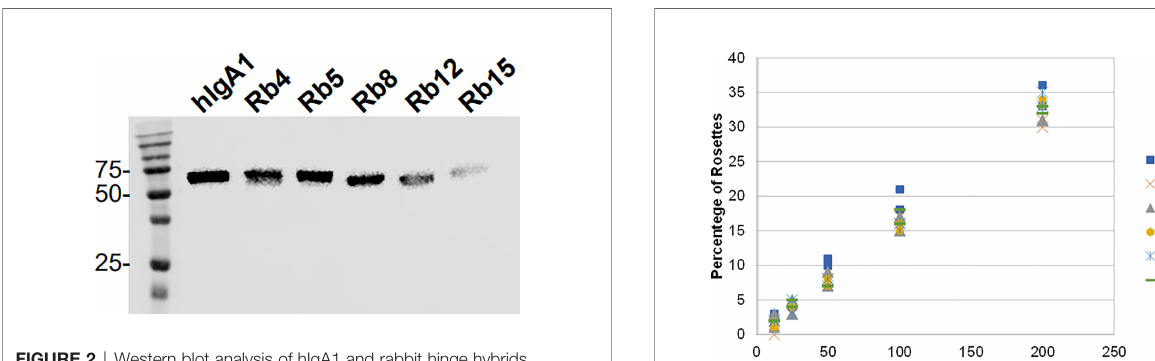
FIGURE 2 | Western blot analysis of hIgA1 and rabbit hinge hybrids separated under reducing conditions and probed with anti-human IgA- peroxidase conjugate. Positions of molecular mass markers in kilodaltons are shown on the left.